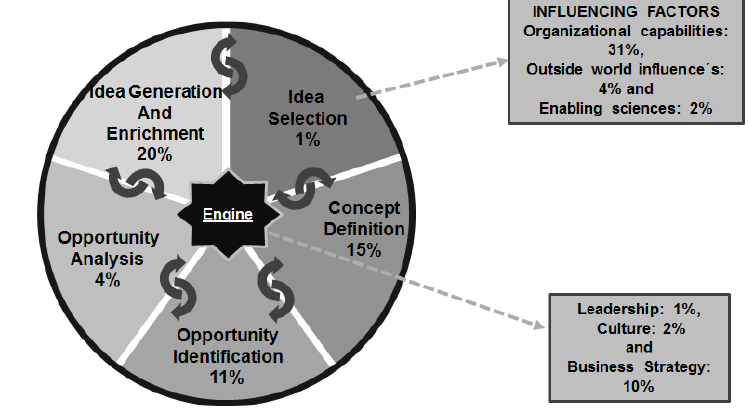
Fig. 7. Research findings through the lens of the NCD